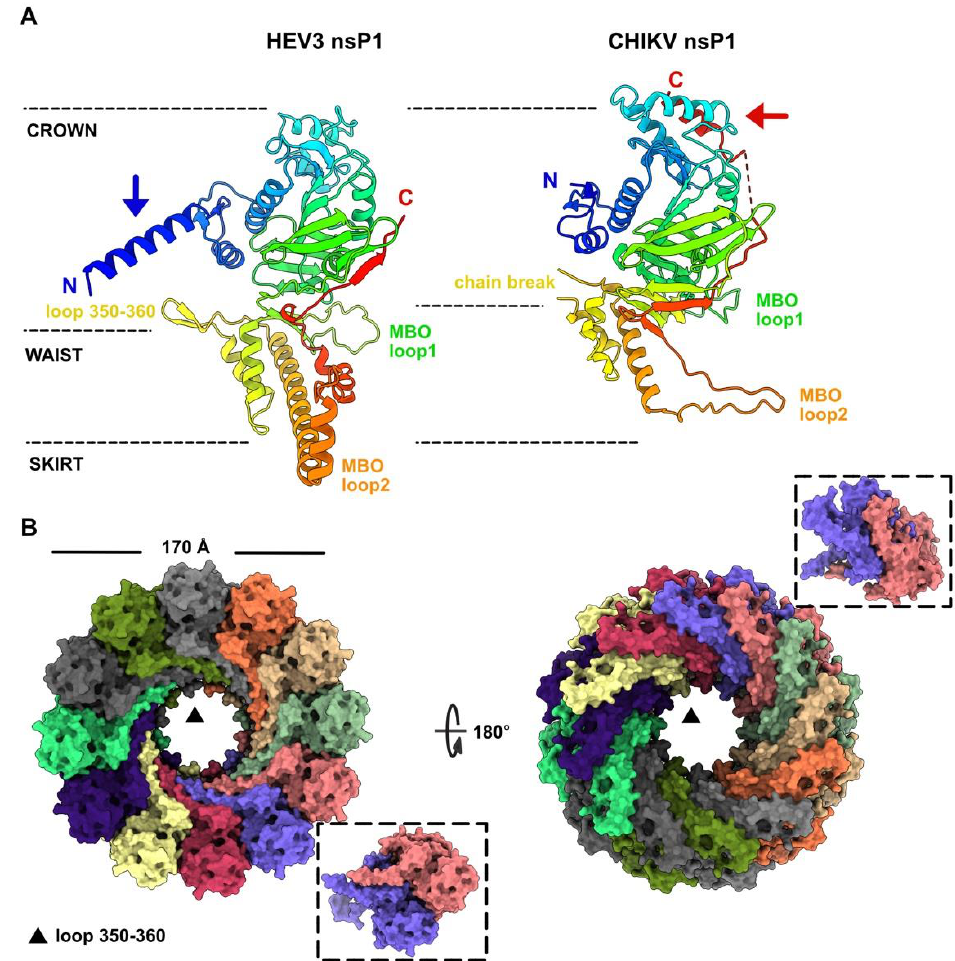
Figure 2. HEV-3 nsP1 predicted structure, a potential capping pore of the replication factory. ( A ) Ribbon representations of HEV-3 nsP1 predicted structure (left) and CHIKV nsP1 cryo-EM structure (right) (rainbow colored). The three nsP1 regions are identified with dashed lines, the membrane- binding and oligomerization (MBO) loops are labelled, and the N- and C-termini are indicated. The blue arrow indicates the position of the N-terminal α -helix in HEV-3 nsP1, and the red arrow indicates the position of the C-terminal α -helix in CHIKV nsP1. ( B ) Surface representation of the HEV-3 nsP1 dodecameric assembly (colored by chain) viewed from the crown (left) and from the MBO loop 2 (right). The insets highlight an AF2 predicted structure of a dimeric HEV3